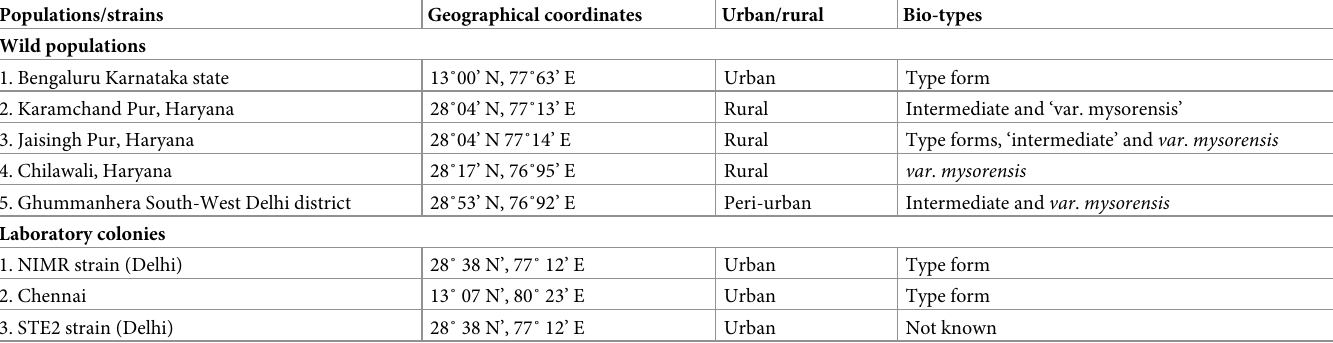
Table 1. Geographical locations of Anopheles stephensi collection sites and other laboratory strains used for molecular studies.